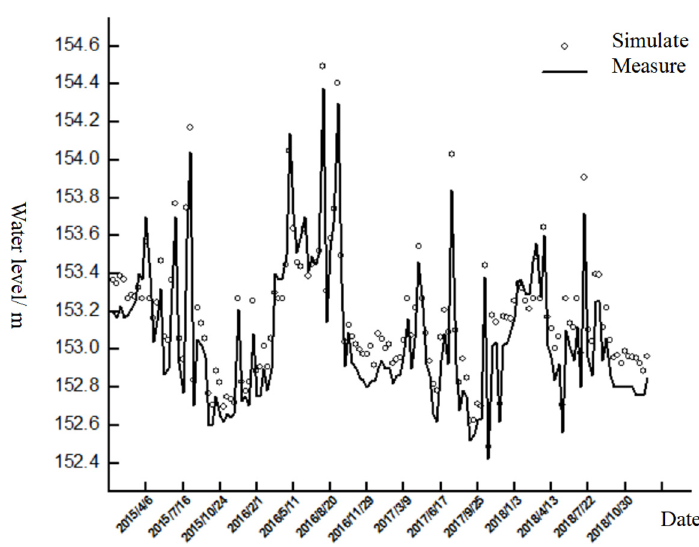
Figure 4. Water level simulation results of hydrological station in Cangshi.